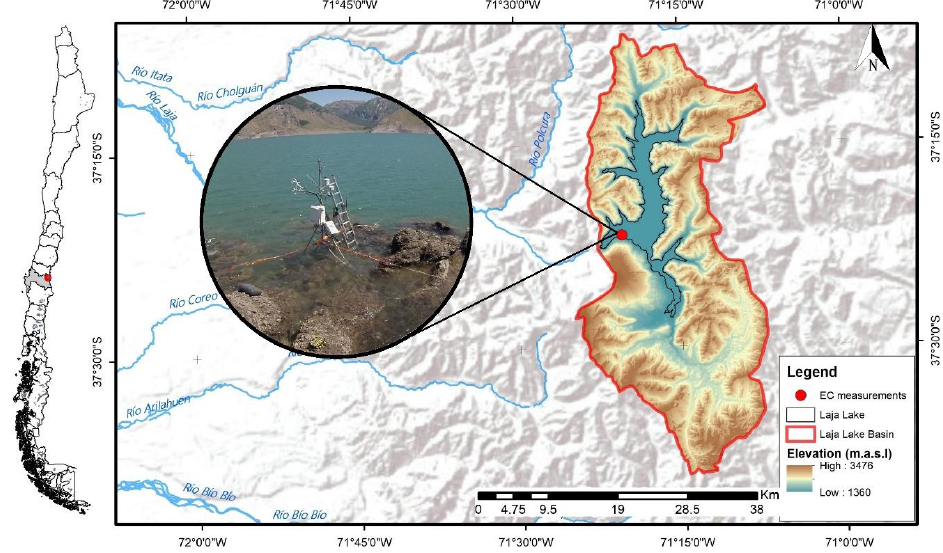
Figure 1. Location of the eddy covariance system.